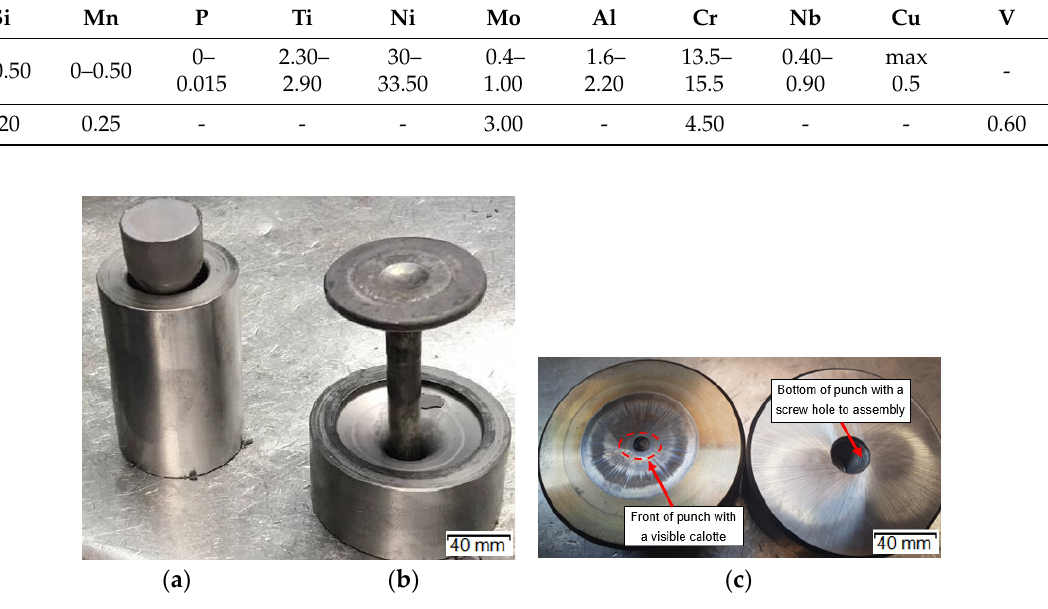
Figure 2. View of the forging and the die: ( a ) after the first operation, ( b ) after the second operation, ( c ) a worn forging punch after 3000 forgings; left—The working part with clear traces of abrasive wear on the surface and in the calotte area, right—The fastening part.